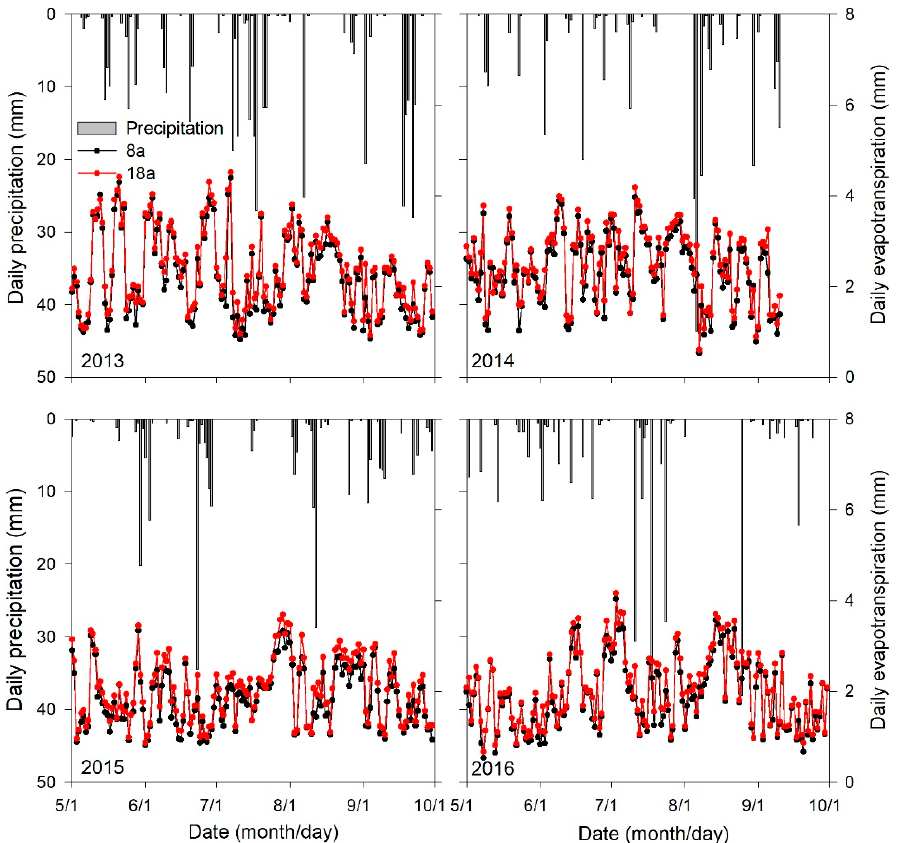
Figure 2. Dynamics of daily precipitation and evapotranspiration for the 8- and 18-year-old apple orchards (8a and 18a, respectively) in 2013, 2014, 2015, and 2016.